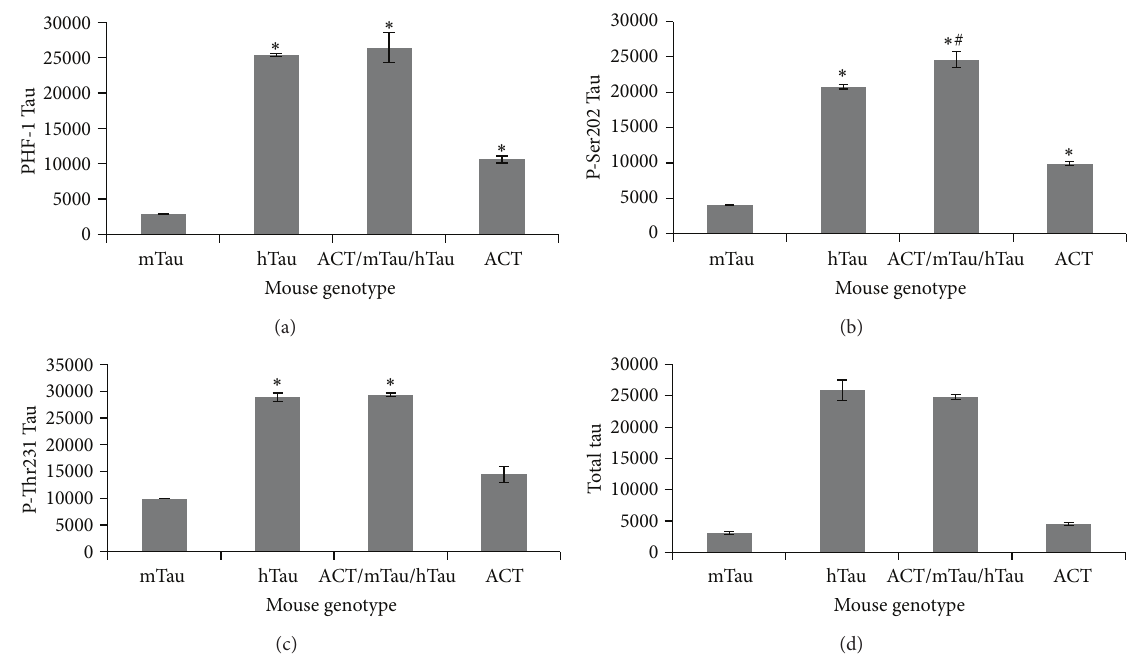
Figure 1: Tau hyperphosphorylation in ACT expressing mice: cortex and hippocampal regions from normal nontransgenic (mTau), ACT expressing(ACT/mTau),humantauexpressing(hTau),andbothACTandhTauexpressing(ACT/mTau/hTau)micewereanalyzedforchanges in phosphorylation of tau at PHF-1 (a), p-Ser202 (b), pThr231 (c) specific epitopes, and total tau (d) using the corresponding P-tau or the TG5 total tau antibody by western blot and quantified using the Image J image analysis software. The data shows significant increase in P-tau levels in ACT and hTau as well as the double transgenic ACT/hTau mice ( ∗ 𝑃 < 0.05 ). Only P-Ser202 tau showed significant change in double transgenic mice compared to mice expressing hTau alone ( # 𝑃 < 0.05